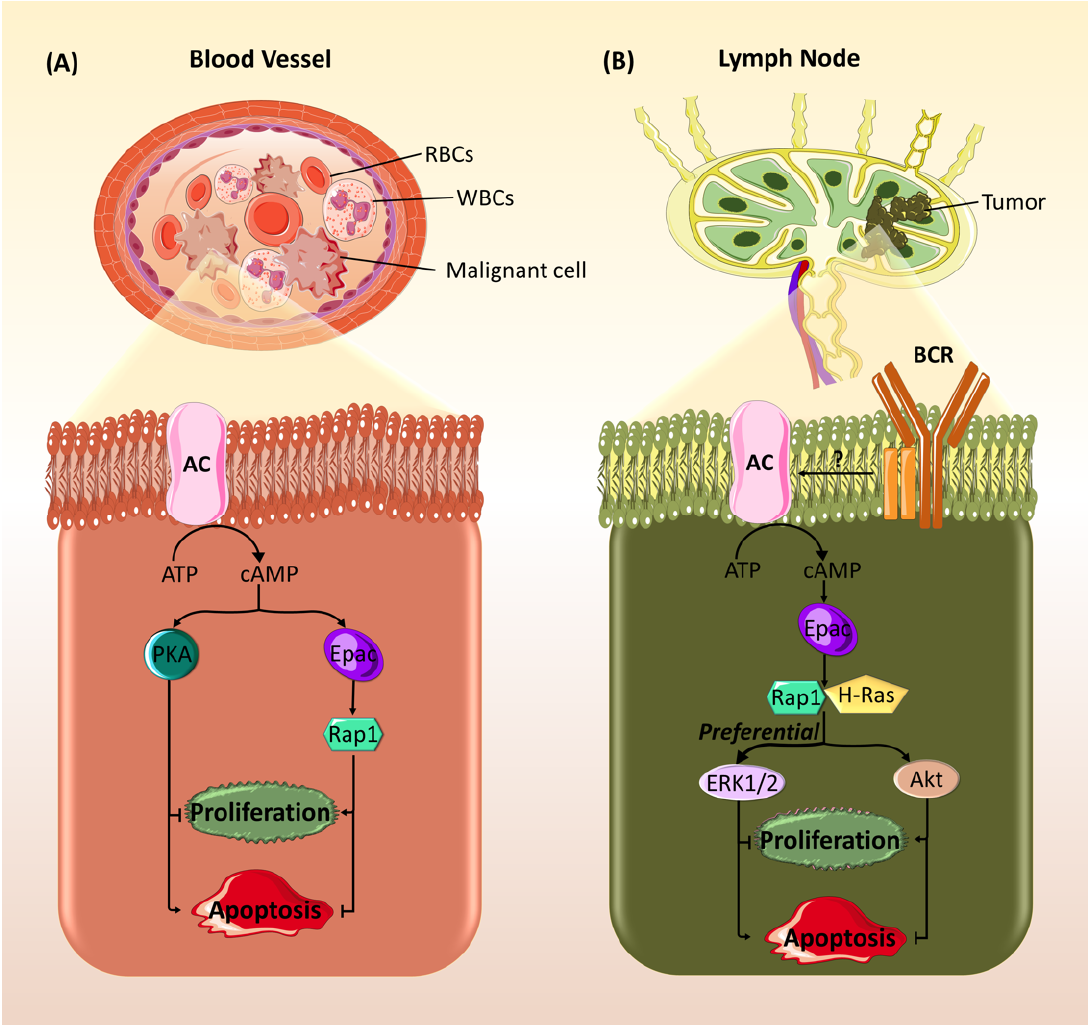
Figure 4. Epac has opposing effects on cell proliferation and apoptosis in different blood cancers types. ( A ) Epac enhances cell growth and survival and inhibits apoptosis in B cell chronic lymphocytic